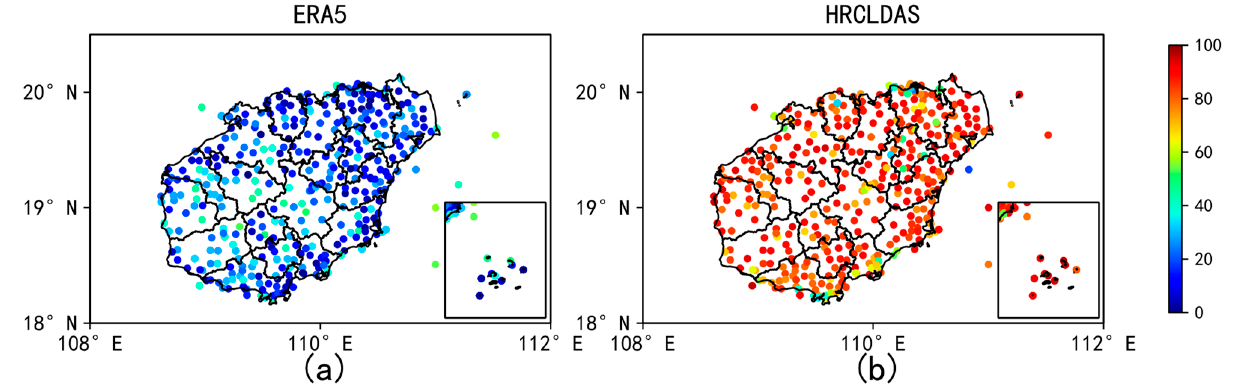
Figure 9. Spatial distribution of wind force grade accuracy. ( a ) ERA5; ( b ) HRCLDAS.